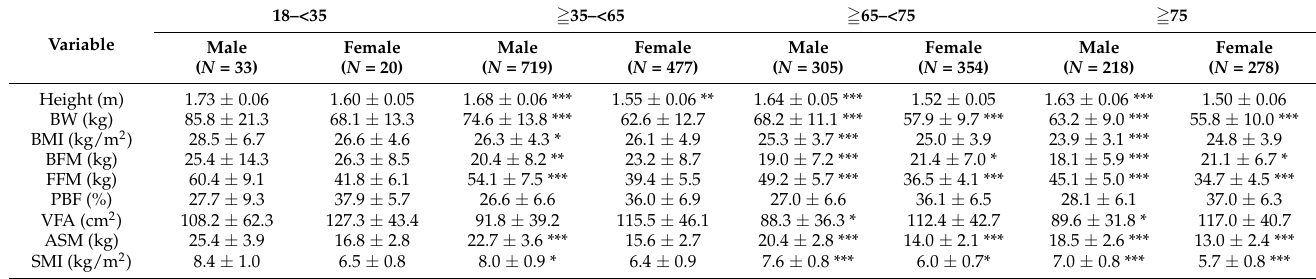
Table 4. Body composition of different age groups and